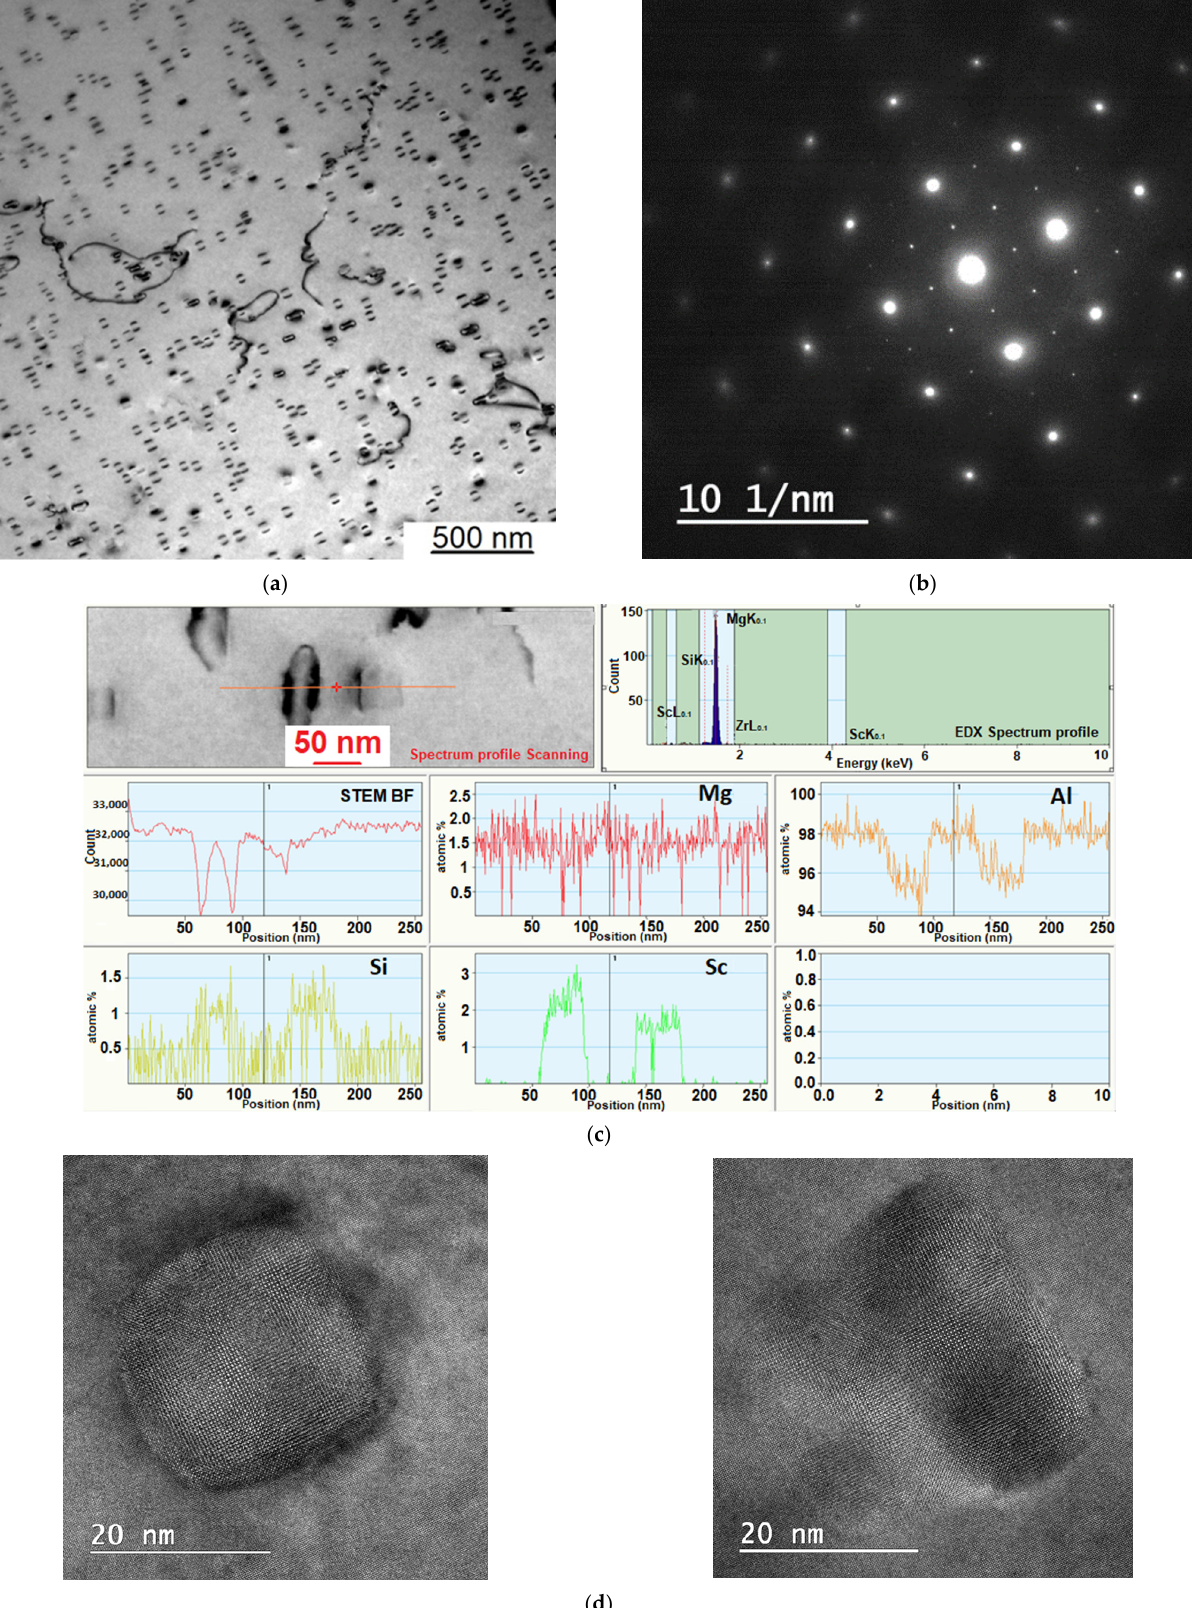
Figure 10. ( a ) (AlSi) 3 Sc coherent and semi coherent particles, ( b ) EDS profile line scan; ( c , d ) direct resolution of the crystal lattice with (AlSi) 3 Sc particles of various sizes.